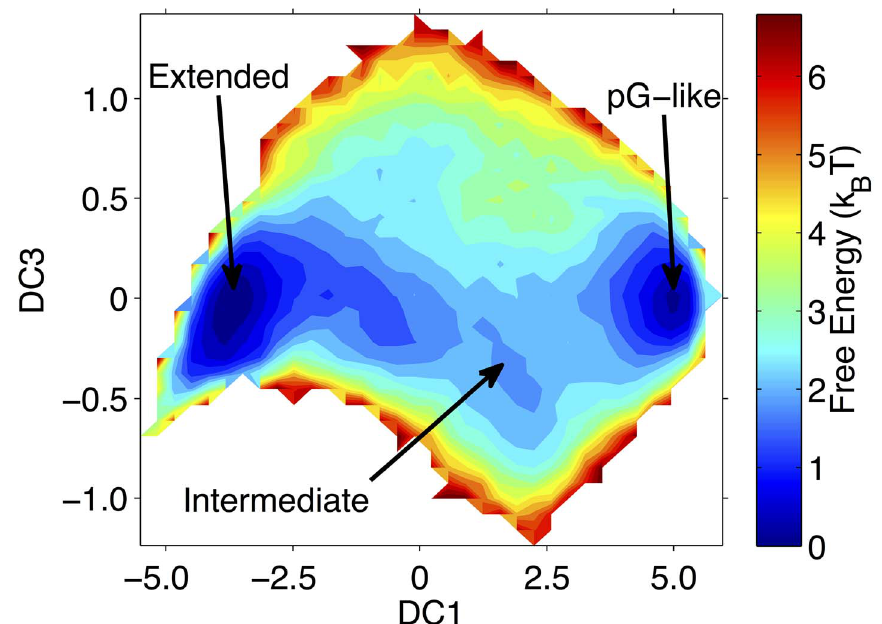
Figure 1. LSDMap of the coarse-grained DMC model of PYP. Structures with large positive first diffusion coordinate (DC1) are globular and similar to the pG state, while structures with large negative DC1 are almost fully extended. The intermediate region near DC1 , 2.5 correspond to potential structures for further consideration as candidate signaling pB-state configurations. Figures S1, S2, and S3 in Text S1 show representative configurations from each region. The free energy is shown in terms of DC1 and DC3 to allow for a clearer view of the intermediate region.